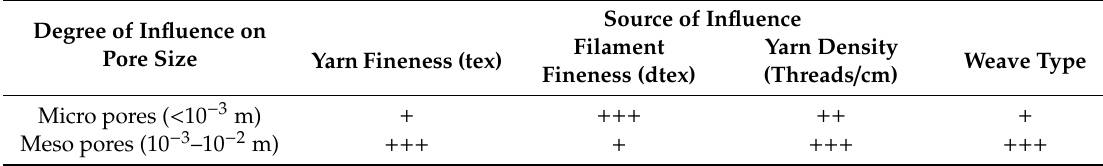
Table 1. Impact of fabrics’ constructional parameters on pore size